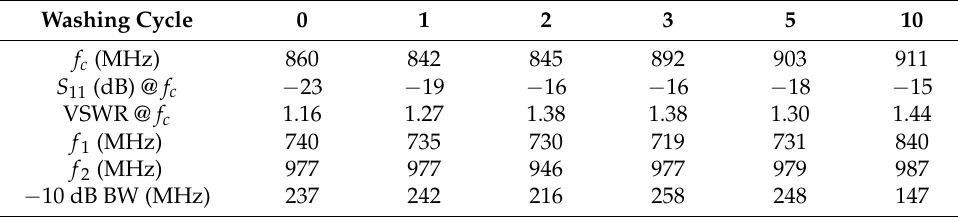
Table 3. Characteristics of the prototype B1Hb, after several washing cycles.